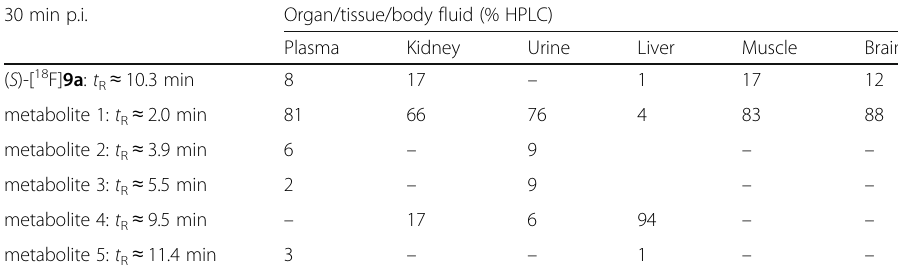
Table 3 Metabolites of ( S )-[ 18 F] 9a in plasma, kidney, urine, liver, muscle and brain 30 min